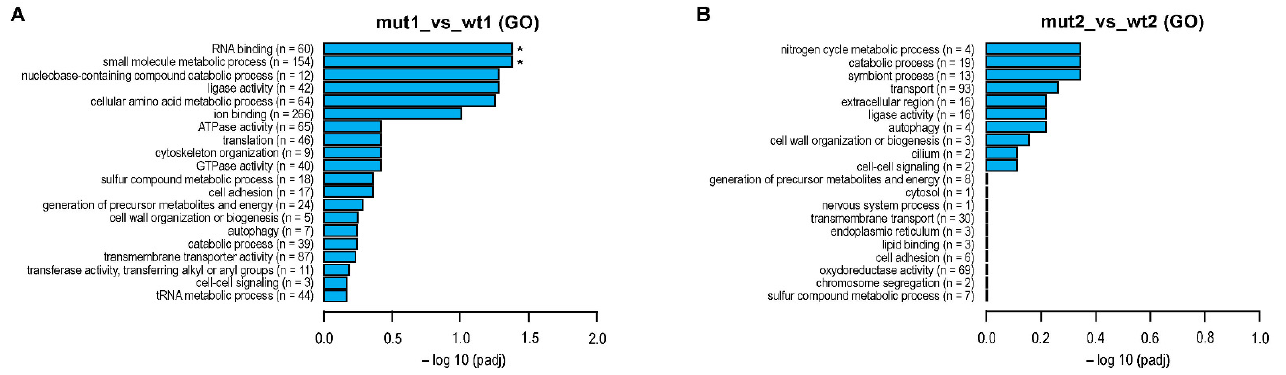
Figure 3. Summarized GO enrichment analysis of detected DEGs. The 20 most enriched GO terms are represented for exponential ( A ) and stationary ( B ) growth phase. The length of bar charts indicates statistical significance of each GO term (* p < 0.05).